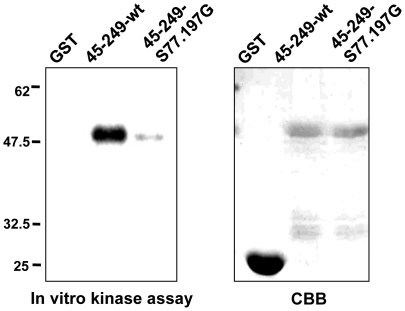
ERK phosphorylates palladin in an in vitro kinase assay.GST-fused residues 45–249 of wild-type or mutant palladin was incubated with active ERK for 10 min at 37°C in the presence of radioactive [γ32−P]-ATP and separated by SDS-PAGE. Left panel shows the phosphorylation of recombinant proteins, and the right panel shows Coomassie blue staining of recombinant proteins.